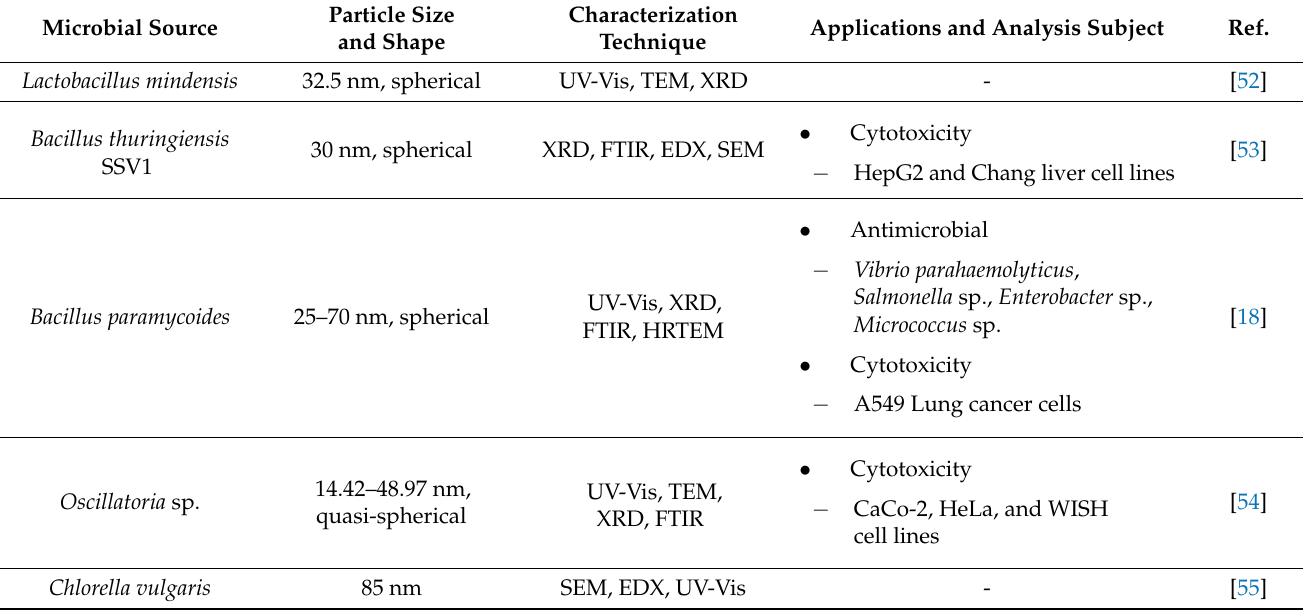
Table 2. Microbe-mediated synthesis of Ag 2